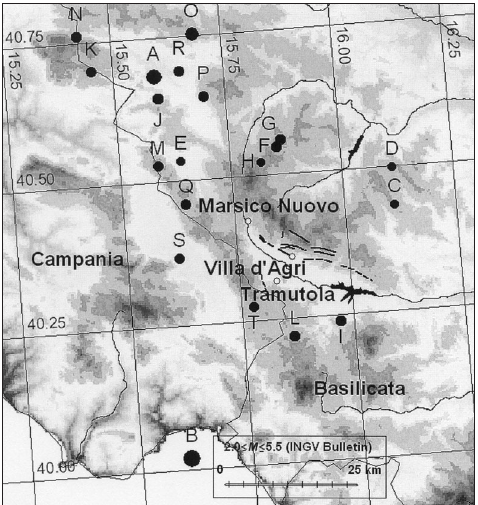
Fig. 2. Spatial distribution of epicentres of the seis- mic events A-T (black dots, see table I) during anom- alous gas flux periods and their relation to the Tra- mutola, Marsico Nuovo and Villa d’Agri station (white circle).